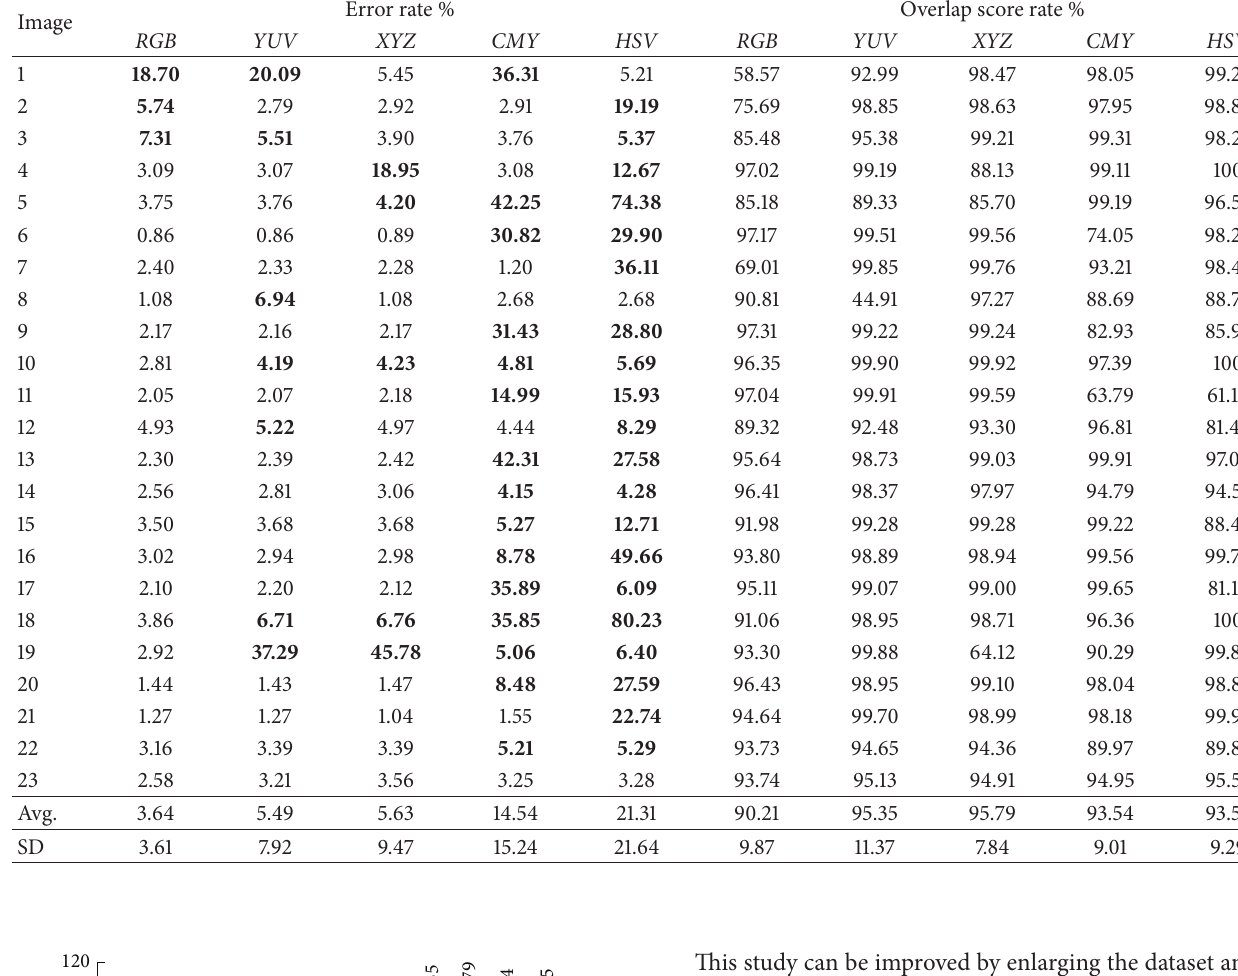
Table 2: Experimental segmentation results on different color spaces using automatic GrabCut.